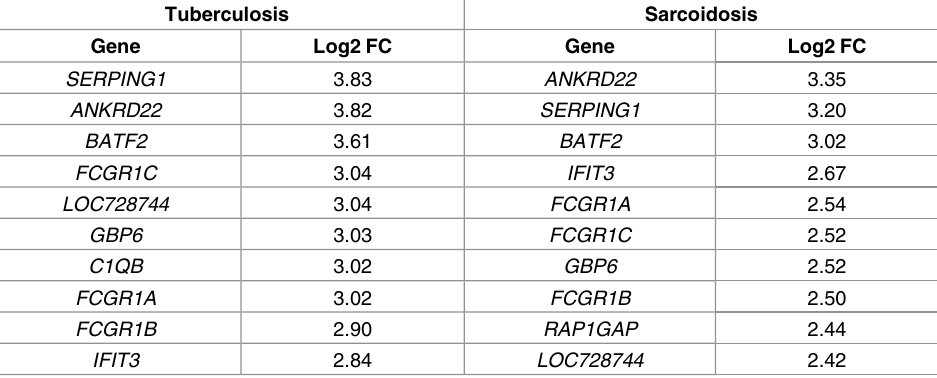
Table 1. Top 10 differentially upregulated genes in TB and sarcoidosis a . Tuberculosis Sarcoidosis